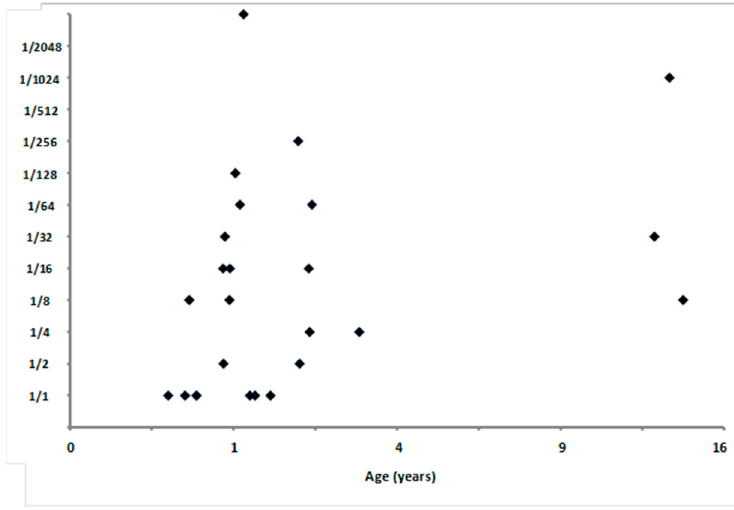
Figure 2. Correlations between maximum post-transplant anti-donor blood group antibodies and the recipient’s age at the time of living donor liver transplantation performed in a series of 34 ABO-incompatible recipients between February 2005 and April 2019 at the Cliniques Universitaires St Luc in Brussels, Belgium. LT: liver transplantation.